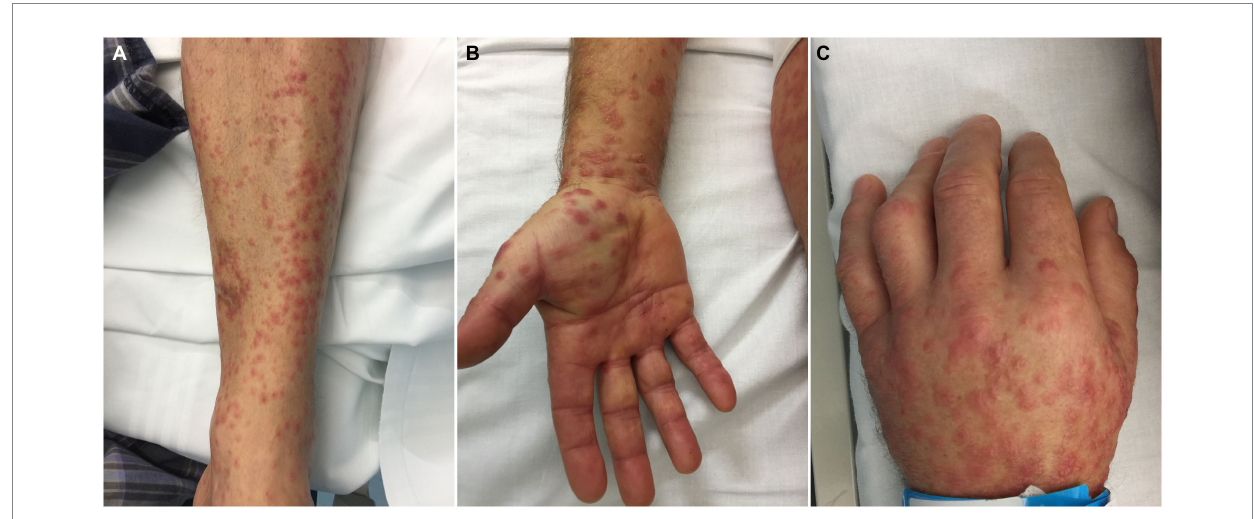
FIGURE 1 Patient 2. Erythematous maculopapular exanthem involving the limbs (A) and acral sites (B,C) . Small vesicles can be observed on the hand dorsum (C)